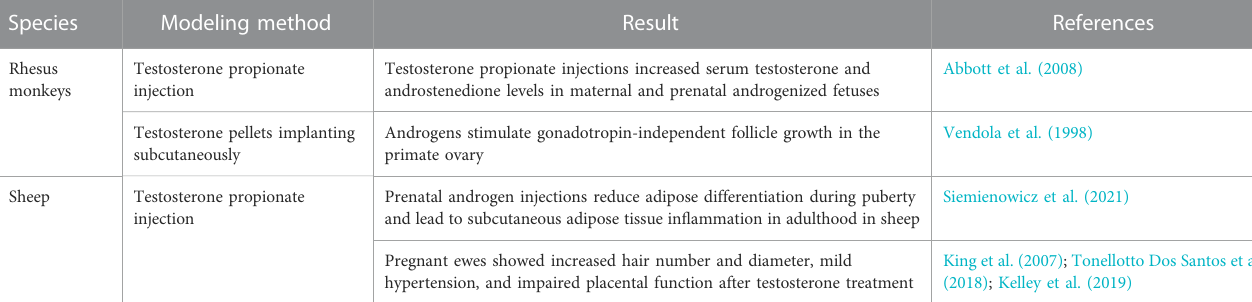
TABLE 3 Large animal models for the study of polycystic ovary syndrome.